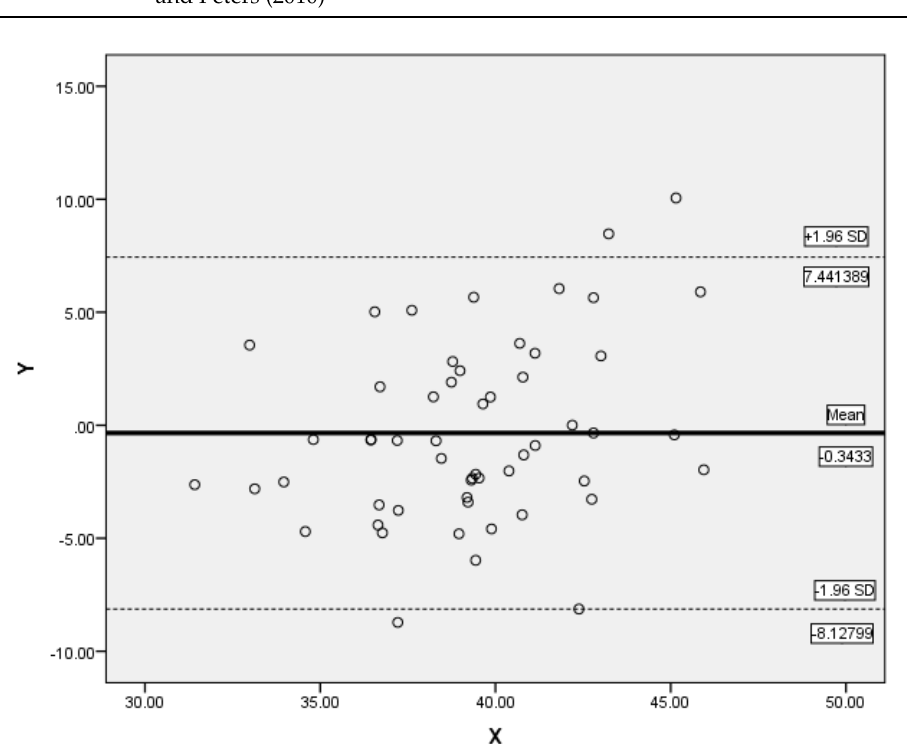
Figure 5. Bland and Altman plot with the representation of the limits of agreement (dotted line), from −1.96 s to +1.96 s, where Y = PNW-RMNW, X = (PNW + RMNW)/2.